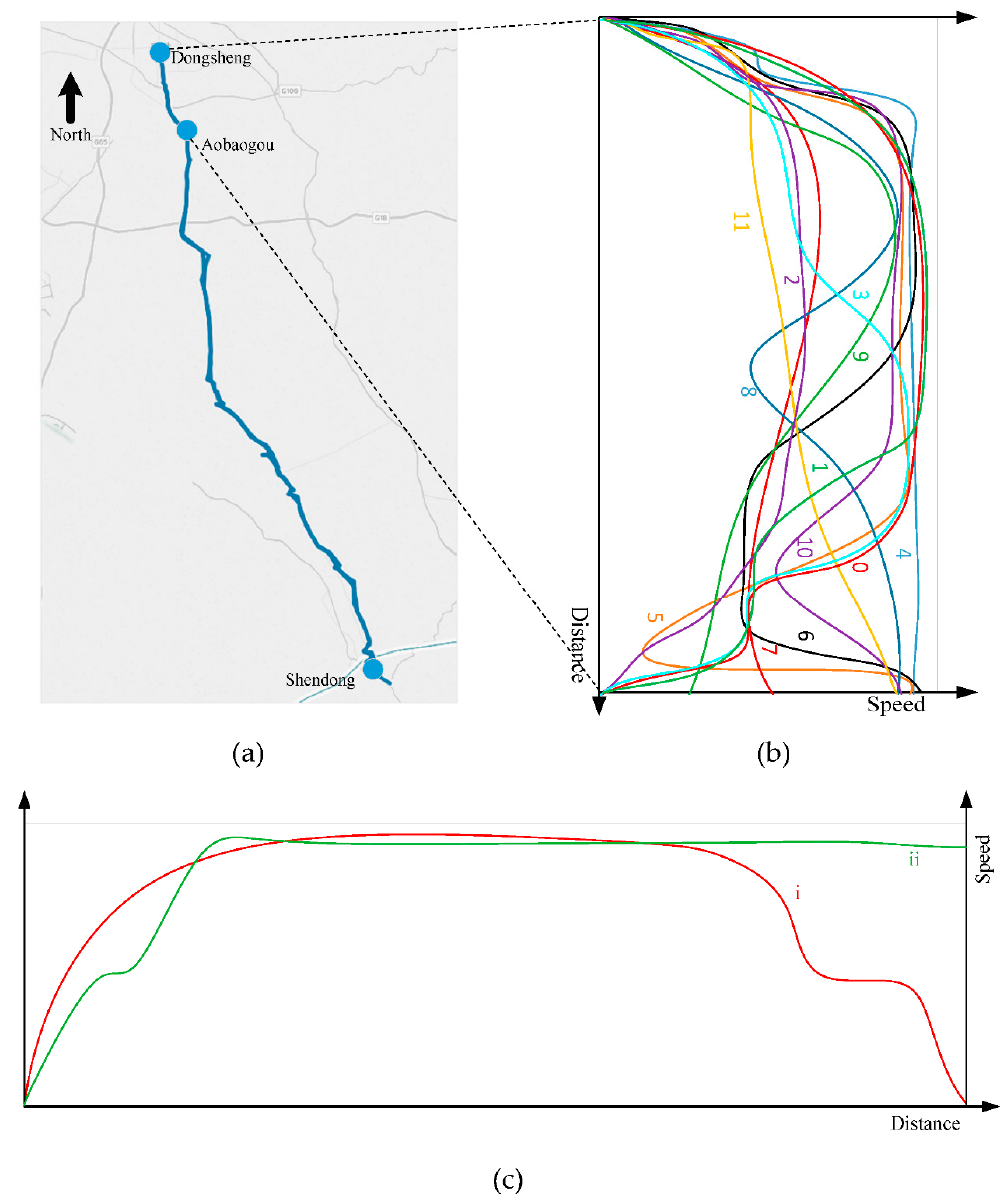
Figure 7. Illustration of Experiment Data. ( a ) The distribution of trajectory data. The Data in section Dongsheng–Aobaogou are used in this experiment; ( b ) Examples of parameters (profiles) of used data; ( c ) Planed Traction Curves (PTCs) i and ii in this experiment, corresponding to two running plans: stop-stop and